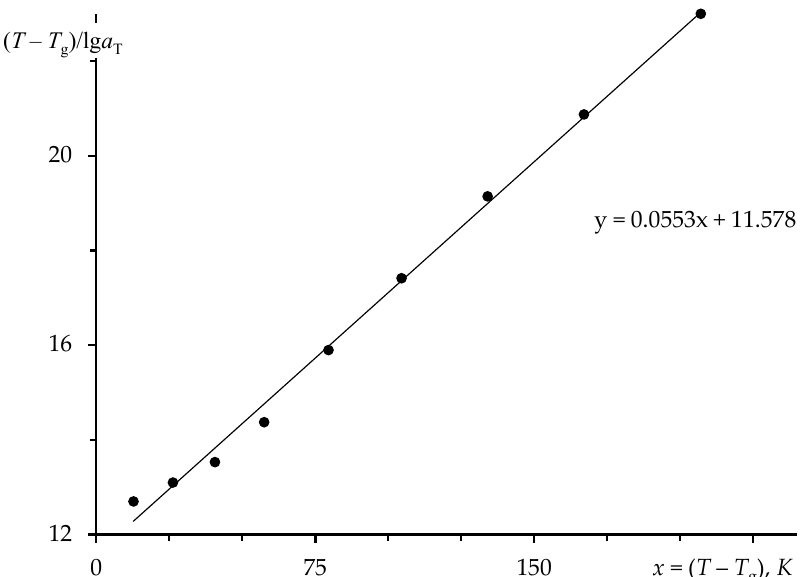
Figure 1. Temperature dependence of the viscosity of As-S glasses in coordinates corresponding to the Williams–Landel–Ferry equation. The data of [18] were used where the composition is as follows: As—32.5 mol%; S—67.5 mol%.